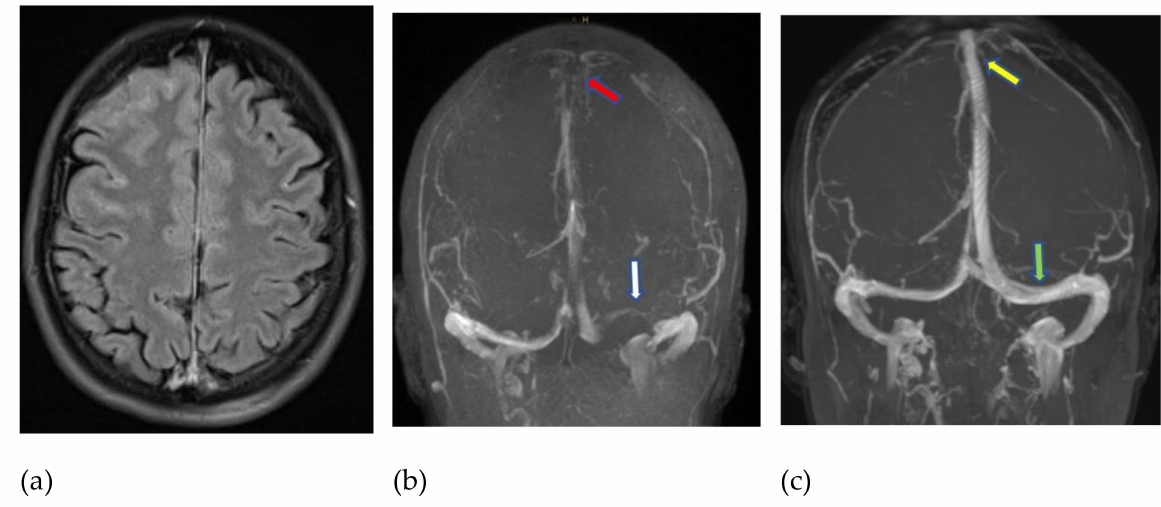
Figure 1. MRI (fluid-attenuated inversion recovery—FLAIR) obtained 7 days after a first AstraZeneca vaccination and immediately after a generalized epileptic seizure, showing blood in the subarachnoid space ( a ). Venous time-of-flight MR angiography ( b ) revealed thrombotic occlusion of the superior sagittal sinus (red arrow) and left transverse sinus (white arrow). An early follow-up examination ten days later ( c ), under full-dose heparinization supported by endovascular thrombectomy of the sinuses, confirmed the recanalization of the superior sagittal sinus (yellow arrow) and left-hand transverse sinus (green